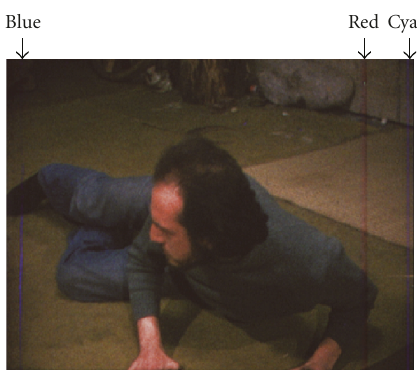
Figure 2: Degraded frame with three common types of scratch. From left to right: blue, red, and